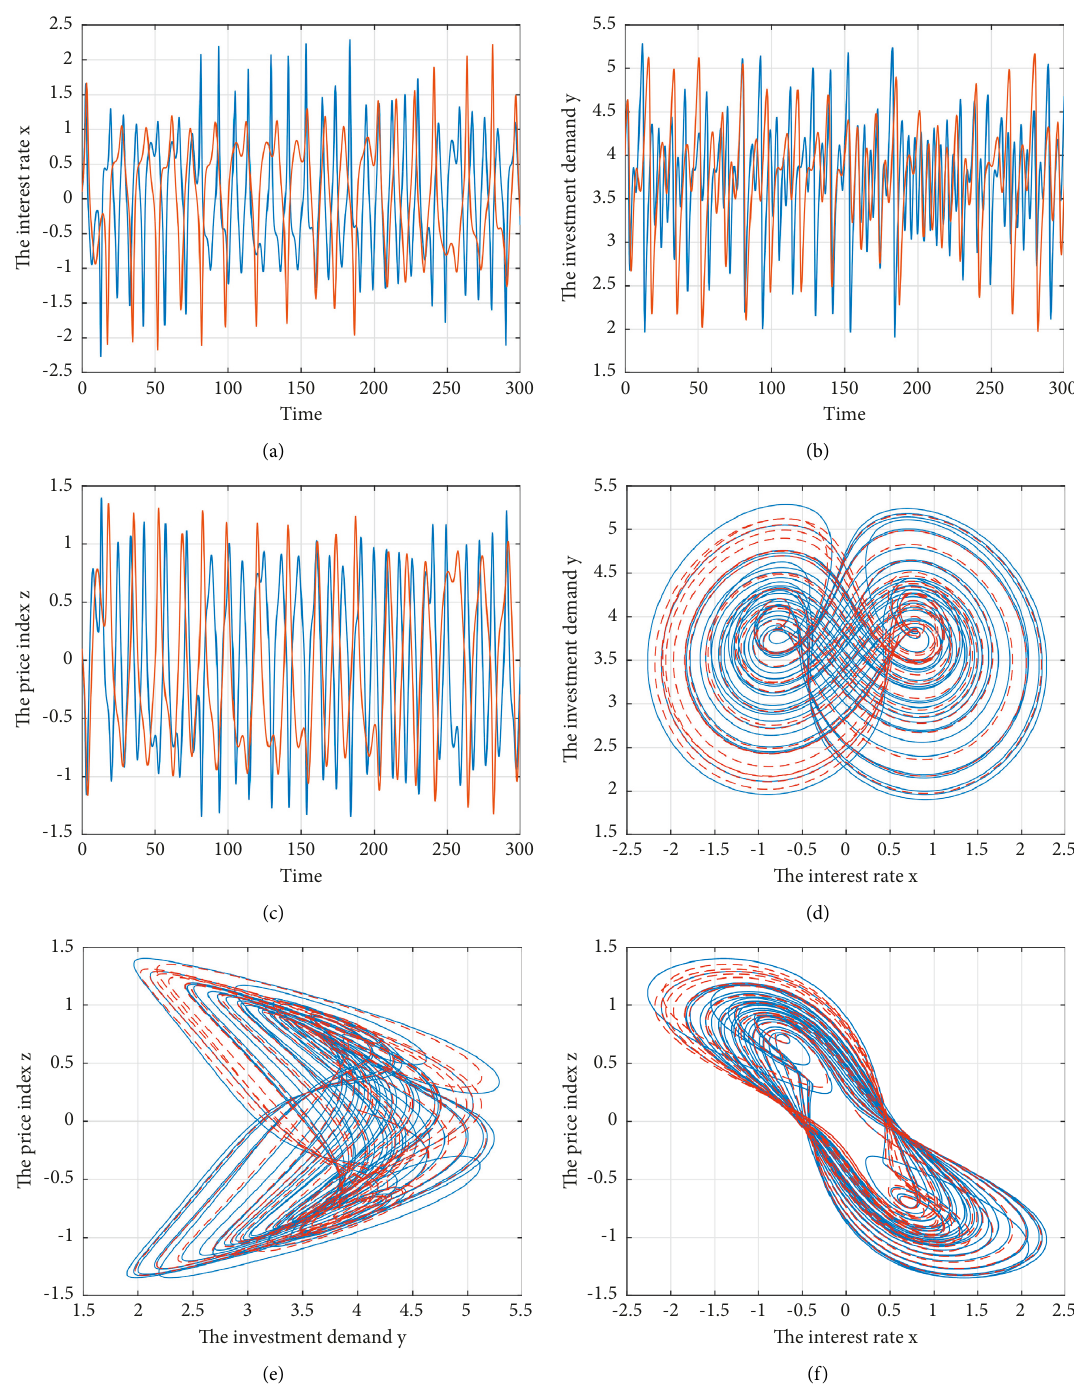
Figure 2: Time series analysis and chaotic behaviour of the proposed fractional model (2) of the financial system with the fractional order ϑ � 0 . 72 to conceptualize the influence of ϑ on the system while the other parameters a , b , and c are